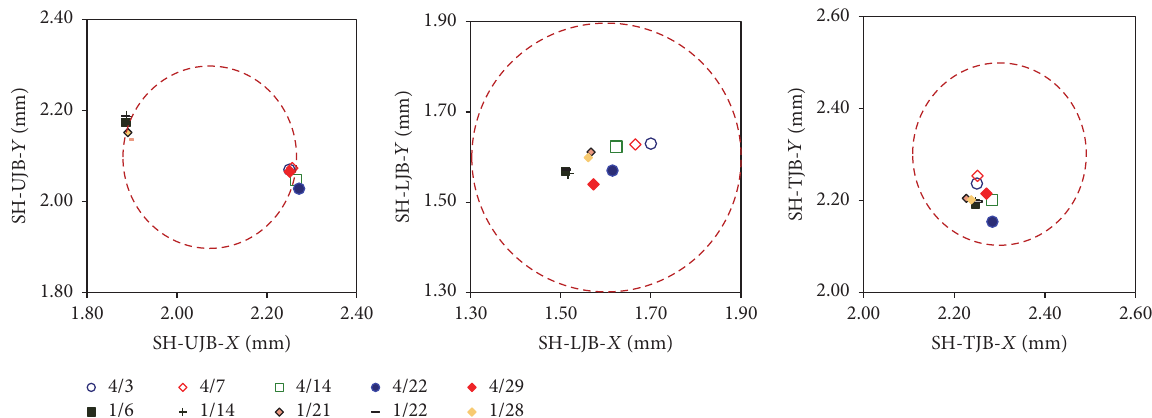
Figure 6: Shaft eccentricity in the upper, lower, and turbine journal bearings of a LHG measured at several loads (from 474 to 694 MW) during several months.